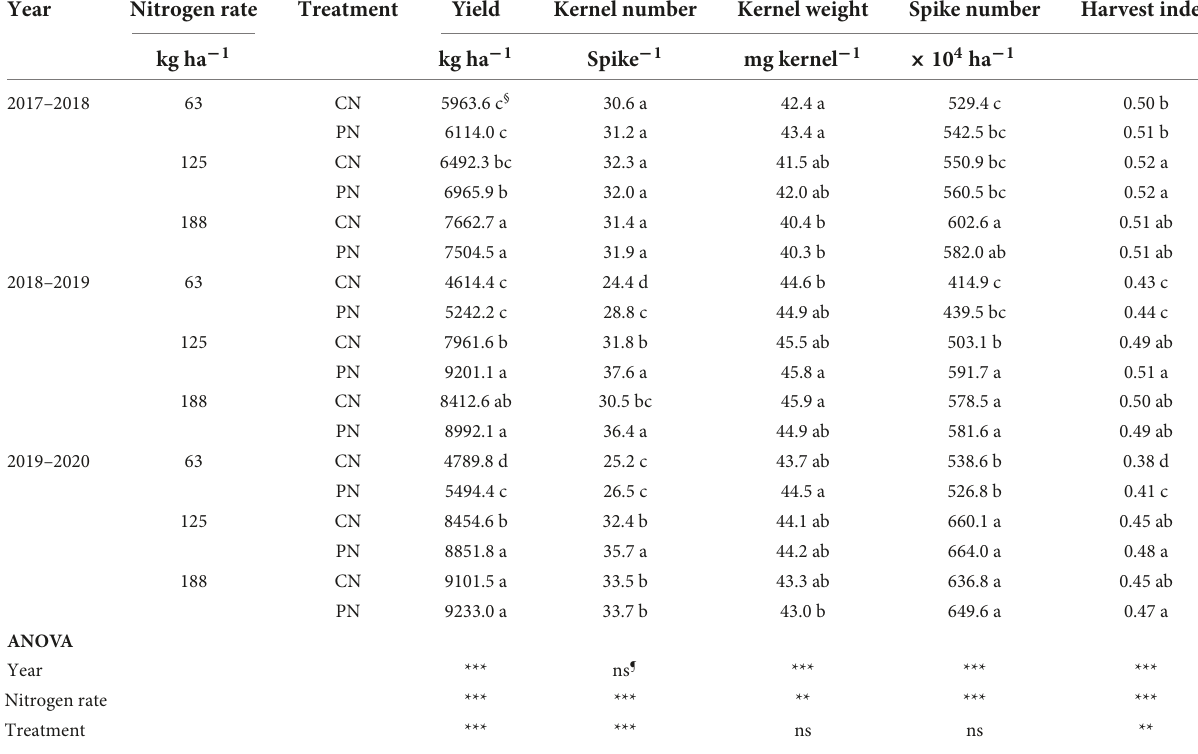
TABLE 3 Wheat yield, yield components (kernel number, kernel weight, and spike number), and harvest index at four N rates under the control (CN) and poly(aspartic acid)-coated urea (PN) treatments from 2017 to 2020. Year Nitrogen rate Treatment